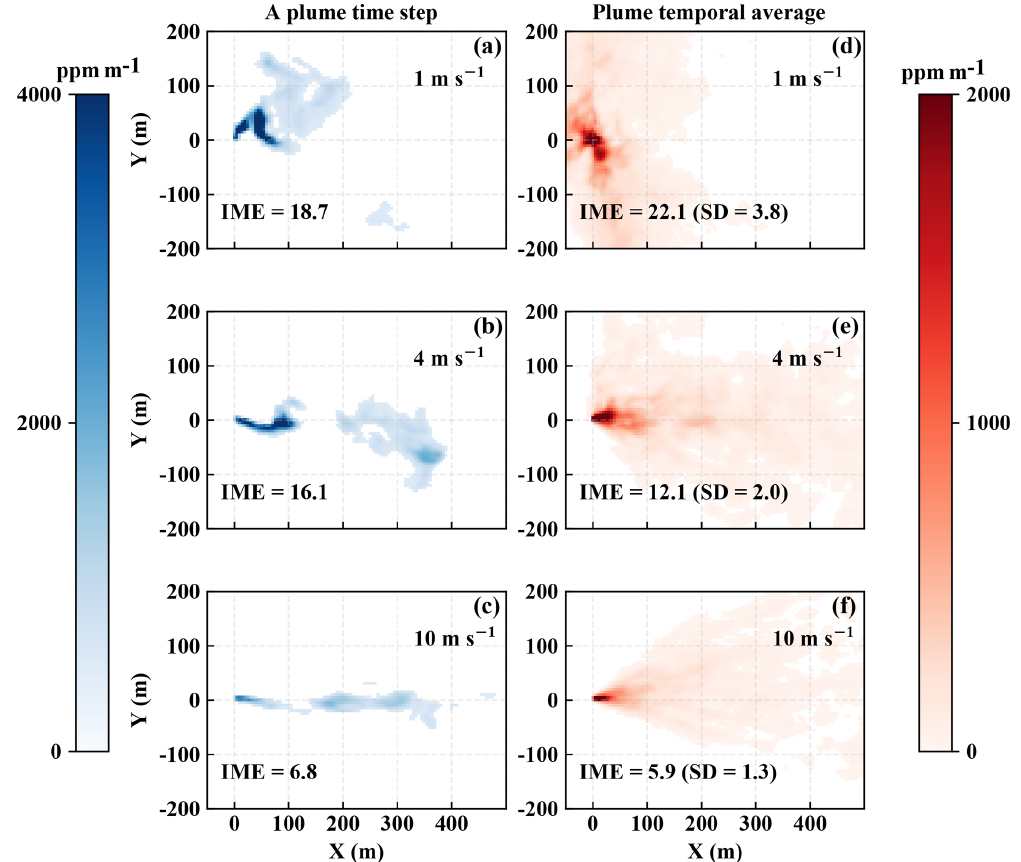
Figure 4. (a–c) Snapshots of simulated plumes under wind speeds of 1, 4, and 10ms − 1 respectively. (d–f) Time-averaged plumes from 60 time steps under the geostrophic wind speeds of 1, 4, and 10ms − 1 respectively. All with a flux rate of 300kgh − 1 and detection threshold set to 500ppmm − 1 . All are based on AVIRIS-NG averaging kernels. The IME is calculated over the entire scene and is in kilograms. Note that the temporal averages do not reach a true ensemble average as sample sizes are finite (i.e., the average still exhibits fine